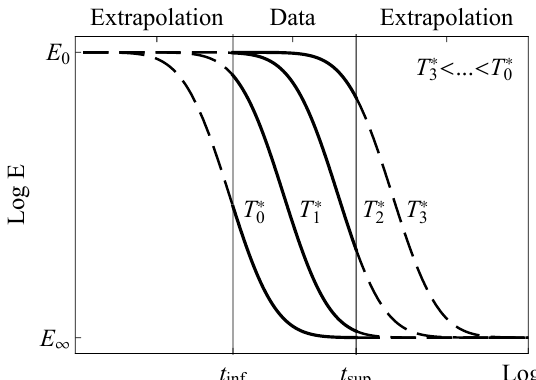
Figure 3. Viscoelastic moduli identified as survival functions for different values of the scale parameter associated with changes of temperature in the Gumbel model, within the experimental window and extrapolated along the